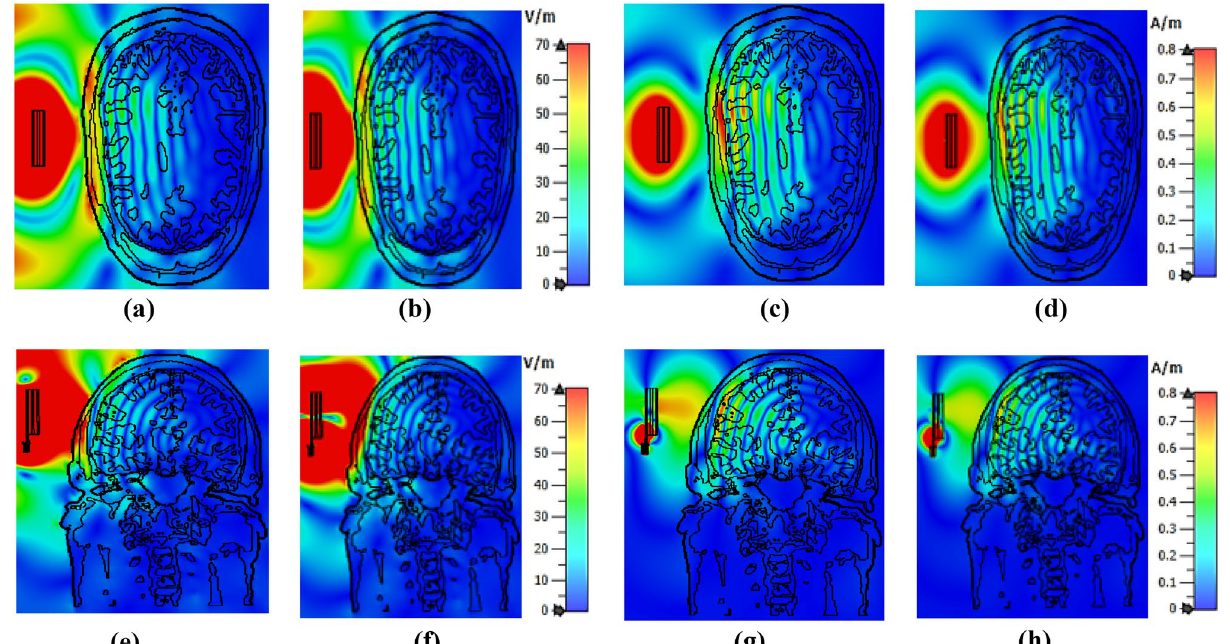
Figure 19. Microwave signal penetration distribution to the head model: ( a ) E-field distribution in xz plane at 2.24 GHz; ( b ) E-field distribution in xz plane at 2.84 GHz; ( c ) H-field distribution in xz plane at 2.24 GHz; ( d ) H-field distribution in xz plane at 2.84 GHz; ( e ) E-field distribution in yz plane at 2.24 GHz; ( f ) E-field distribution in yz plane at 2.84 GHz; ( g ) H-field distribution in yz plane at 2.24 GHz; ( h ) H-field distribution in yz plane at 2.84